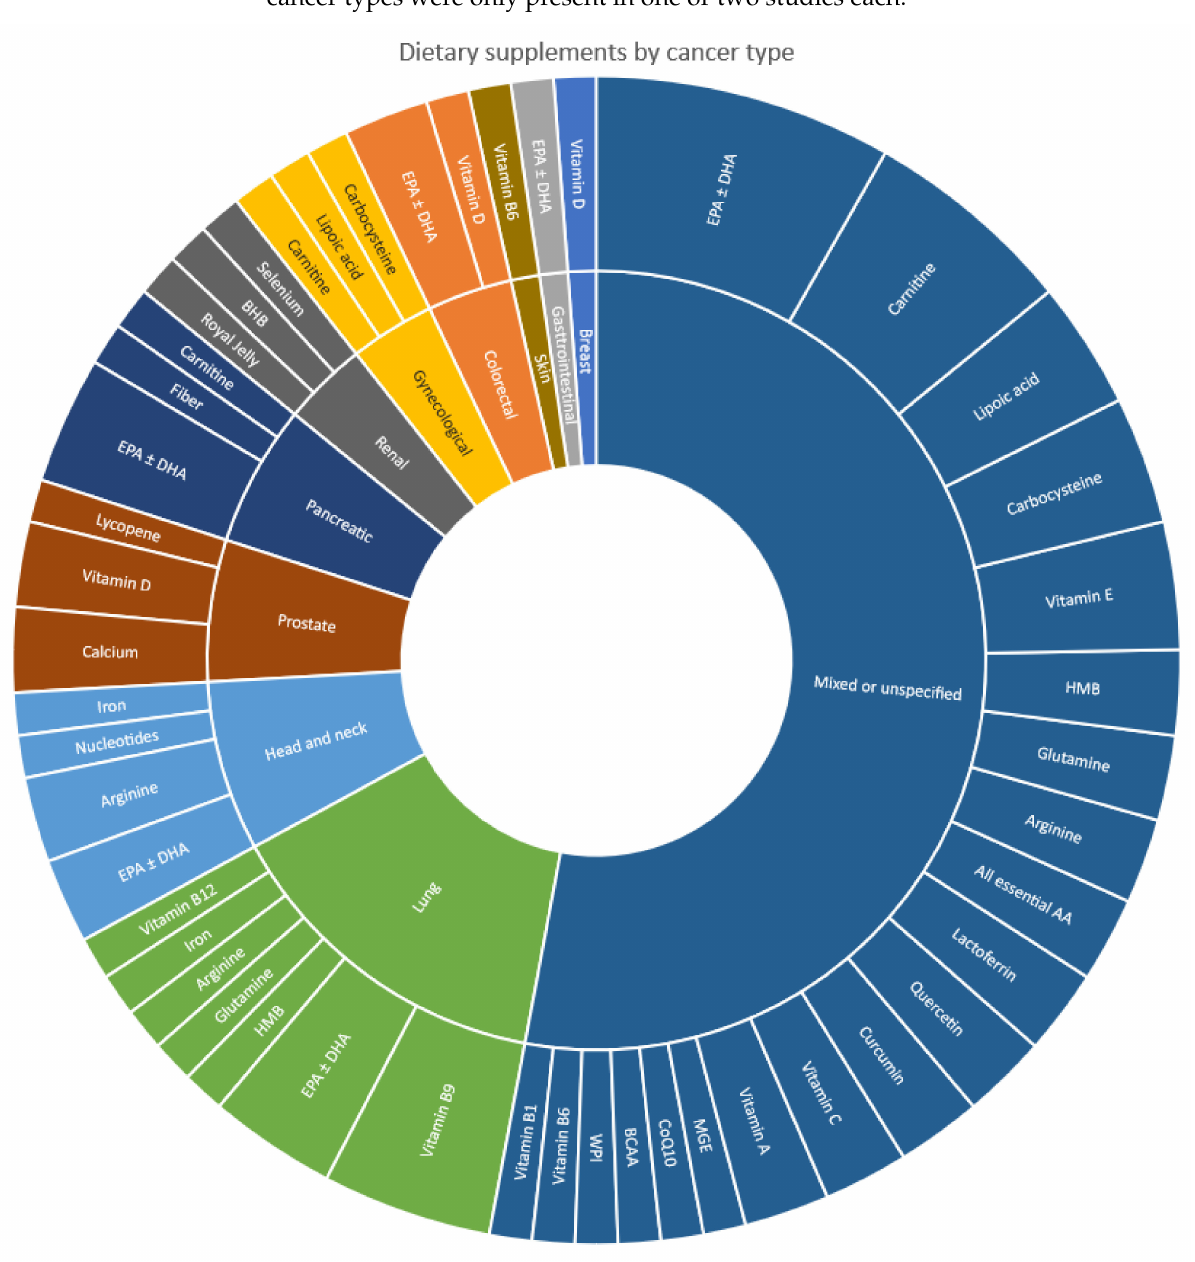
Figure 2. Types of dietary supplements included in studies, according to cancer